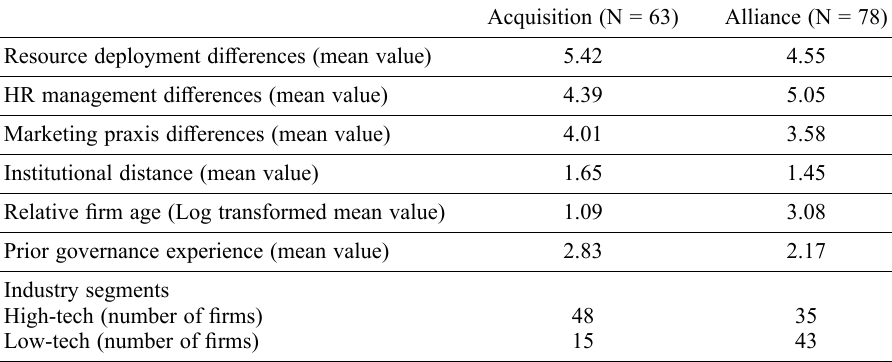
Table 2. Respondent firm profiles (N =